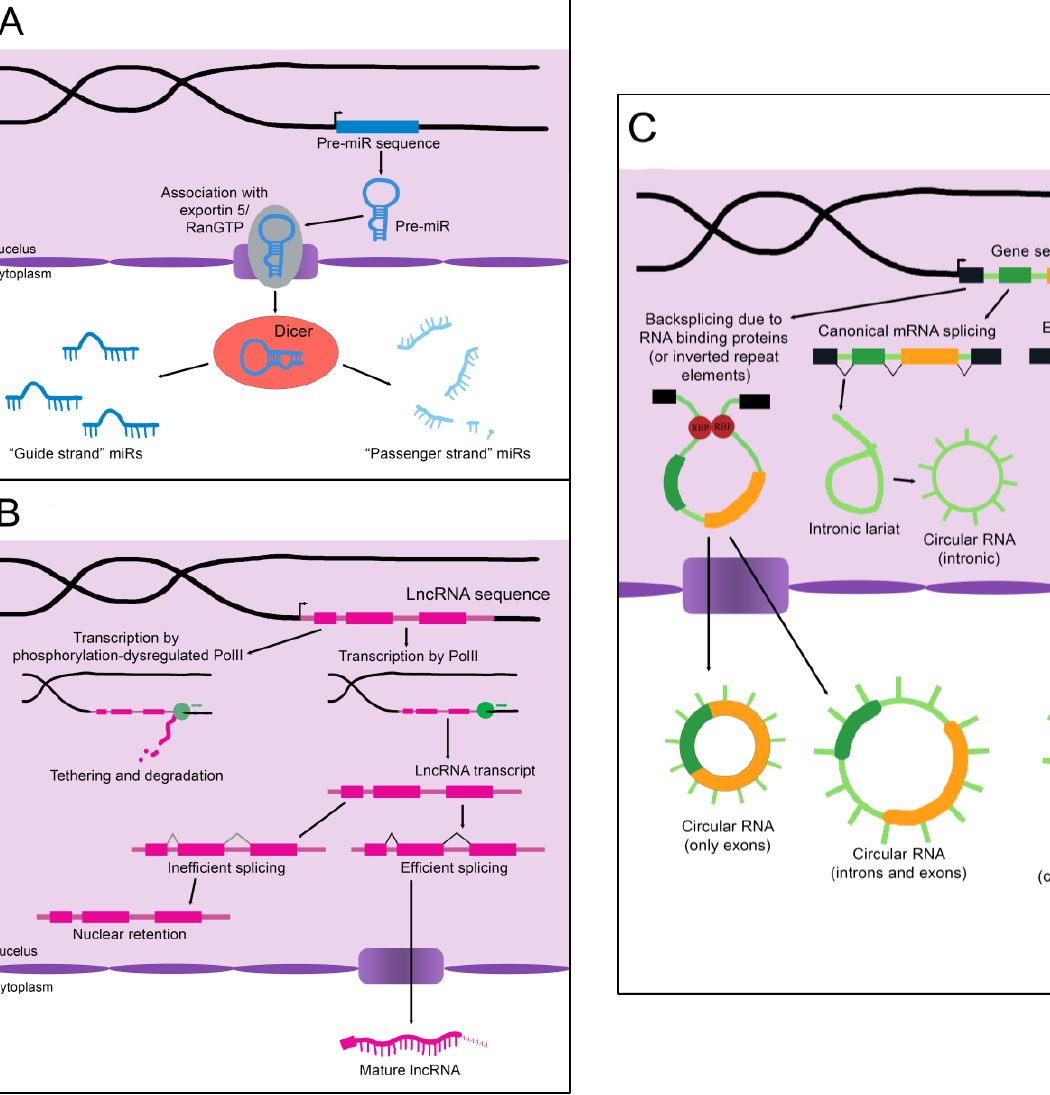
Figure 1. The biogenesis of non-coding RNAs. ( A ) An immature miR transcript is transcribed and exported into the cytoplasm by Exportin 5 bound to Ran-GTP. The “guide” and “passenger” strands are created when the Dicer nuclease splits and processes these precursors. ( B ) The sequence of a lncRNA is transcribed by RNA polymerase II (PolII) and either spliced to its mature form or inefficiently spliced and retained in the nucleus. Alternatively, the sequence is transcribed by phosphorylation-dysregulated PolII, remains tethered to the chromatin, and either accumulates over time or is degraded. ( C ) CircRNAs are created through back-splicing mediated by RNA binding proteins, inverted repeat elements, or lariats created during mRNA splicing. The mature circRNA may contain only exons, only introns, or a combination of both. RBP: RNA-binding protein.